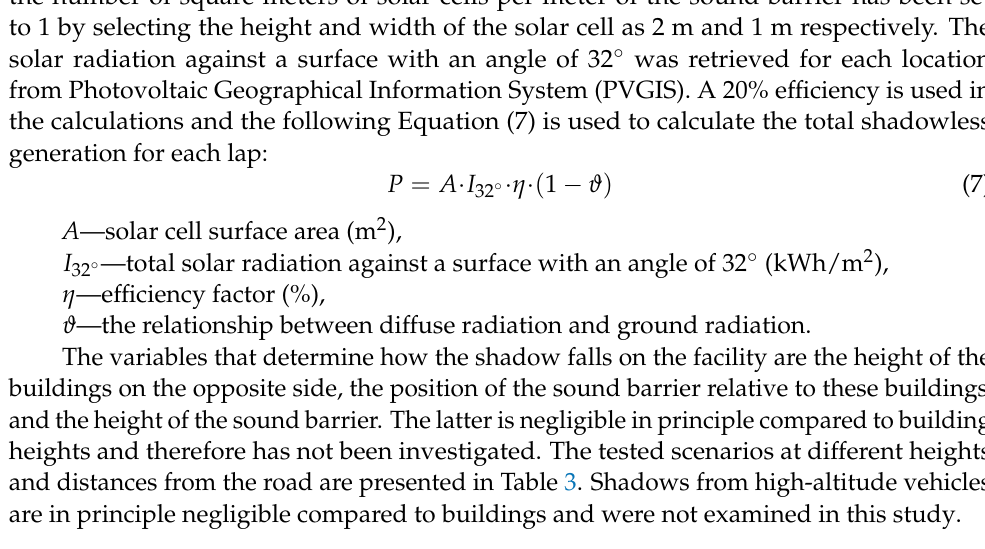
Table 3. The lengths of the buildings by the roadside for analyzing the shadow. Distance from Road